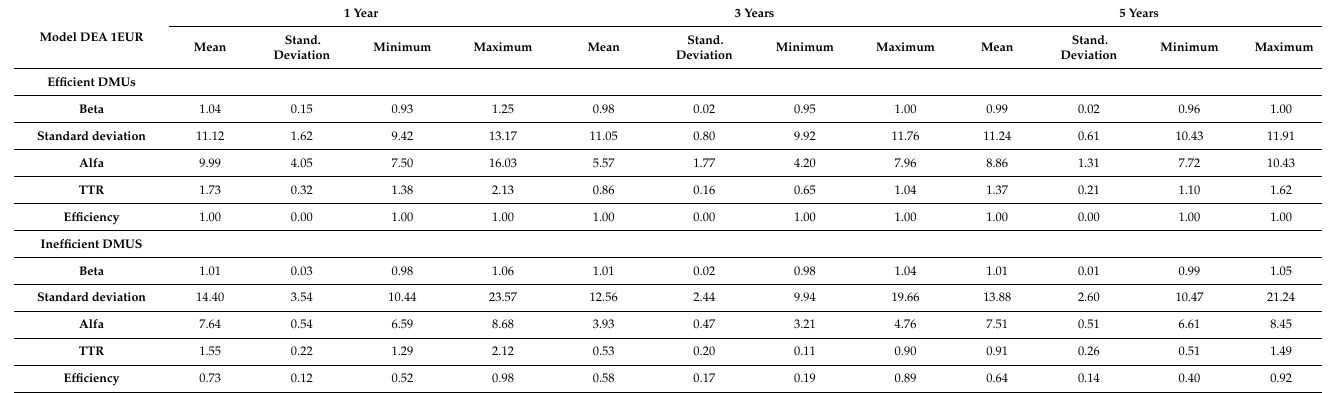
Table A14. Descriptive statistics of efficient and inefficient DMUs (EUR. M1).